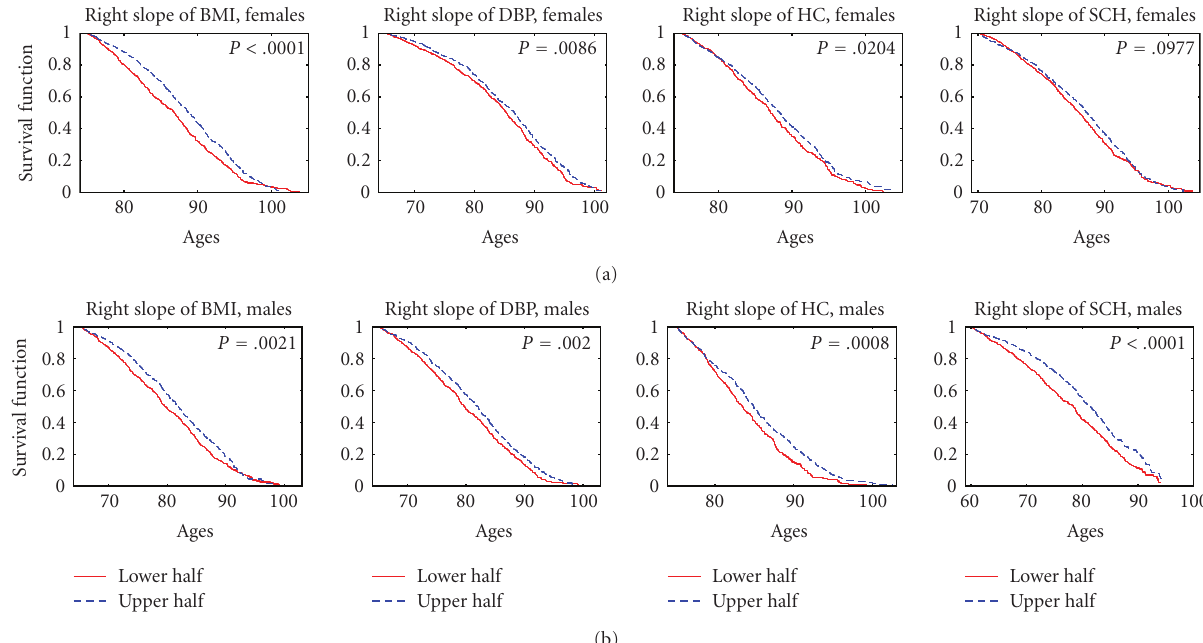
Figure 3: : Kaplan-Meier estimates of survival functions for females (a) and males (b) having the average rate of decline of di ff erent physiological indices after reaching the maximum (“right slope,” see Section 2) from the lower and upper halves of empirical distributions of this risk factor for respective indices; P denotes P value for the null hypotheses about the equality of the survival curves in the strata evaluated by the log-rank